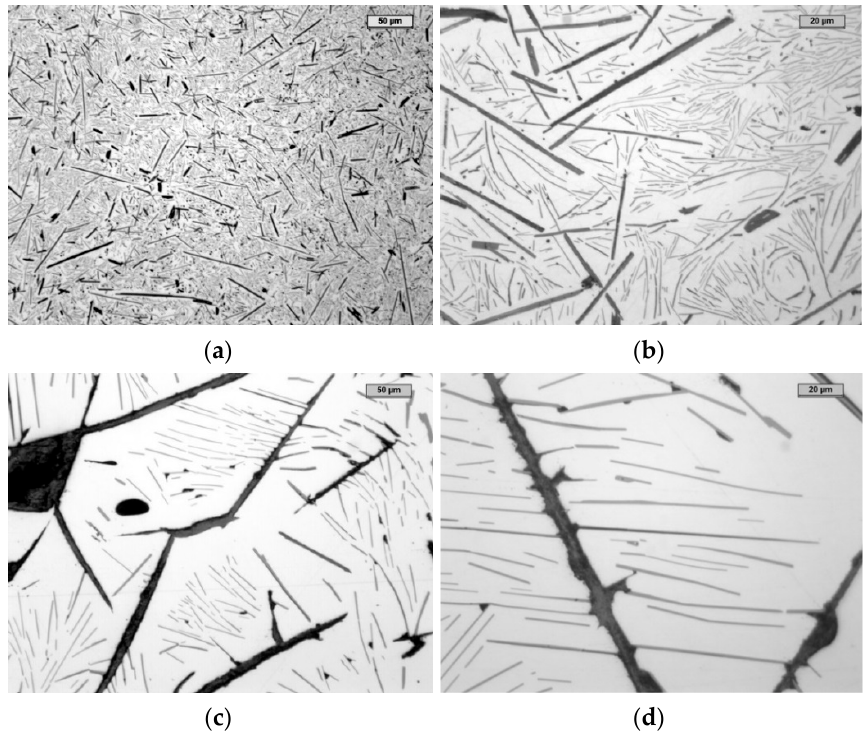
Figure 10. The microstructure of the reference sample cooled at 300 °C/s ( a , b ) and at 10 °C/h ( c , d